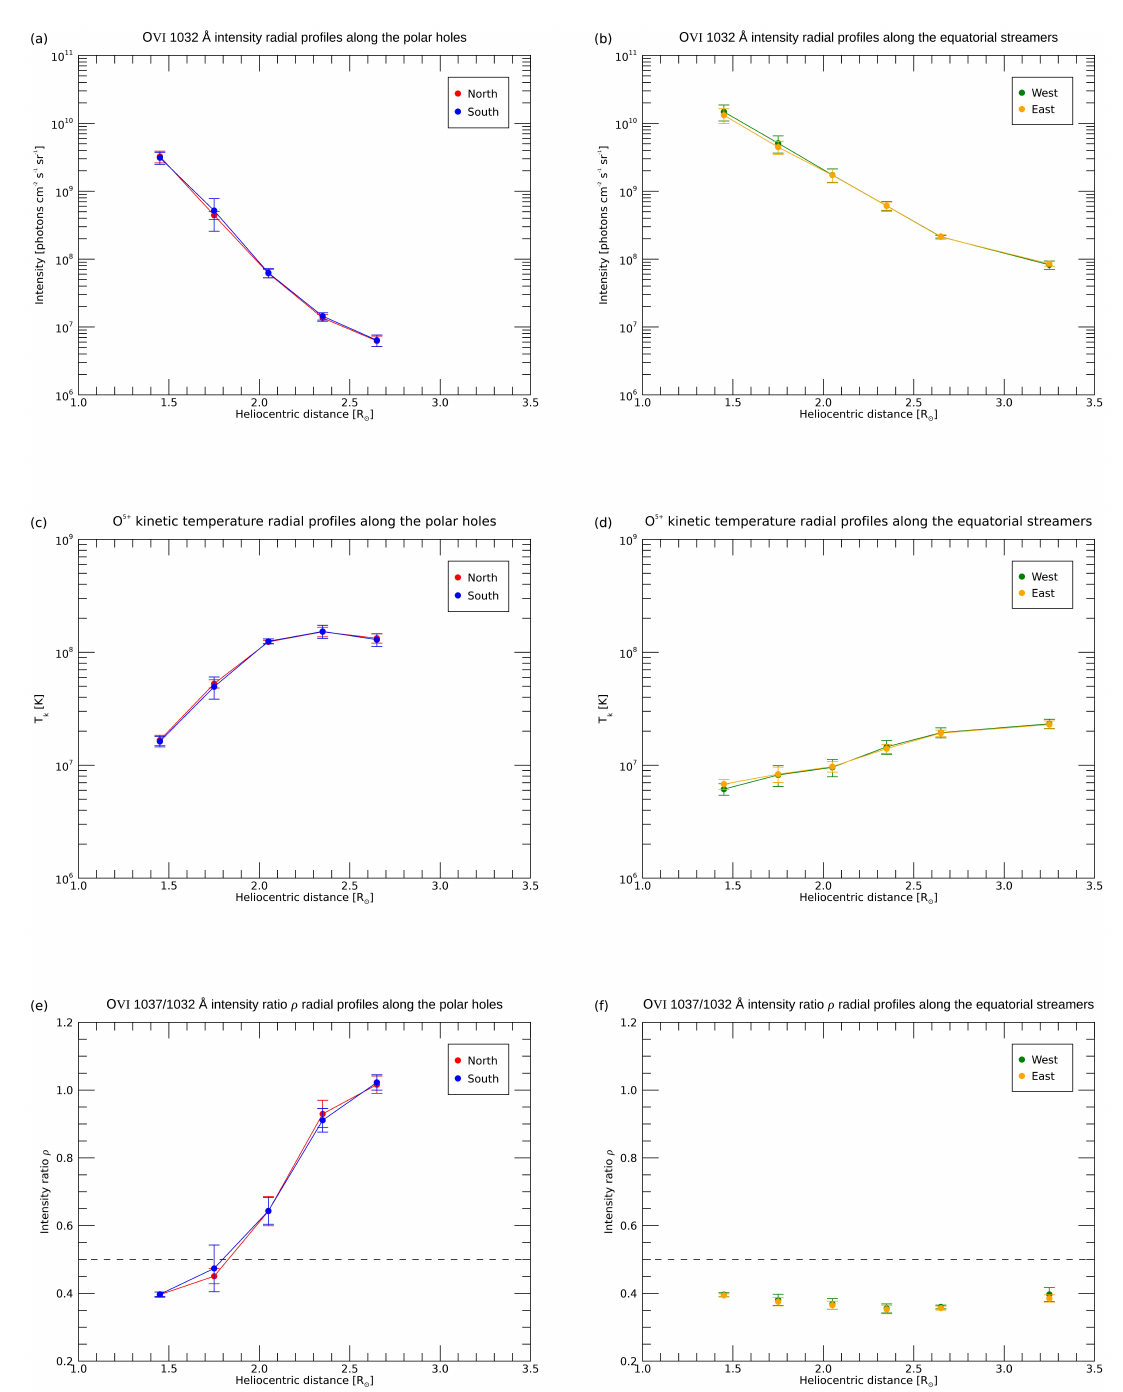
Figure 2. Radial profiles of the O VI 1032 Å line intensity along coronal hole cores ( a ) and equatorial streamers ( b ). Analogous polar/equatorial radial profiles but for the O 5 + kinetic temperature and O VI 1037/1032 Å doublet intensity ratio ρ are shown in ( c – f ), respectively. Red, blue, green and orange colors refer to North and South poles, and to west and east limbs, respectively. Standard deviation error bars are also displayed. The horizontal dashed ρ = 0.5 line in ( e , f ) indicates an expansion rate of about 100 km s − 1